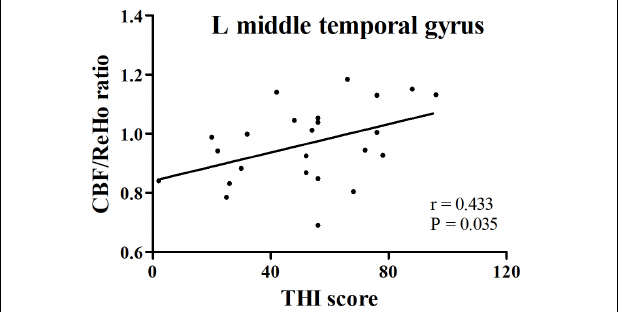
FIGURE 3 | The correlation between CBF/ReHo ratio in the left middle temporal gyrus in PT patients and THI score. PT: pulsatile tinnitus; NC: normal control; CBF: cerebral blood flow; ReHo: regional homogeneity; THI: Tinnitus Handicap